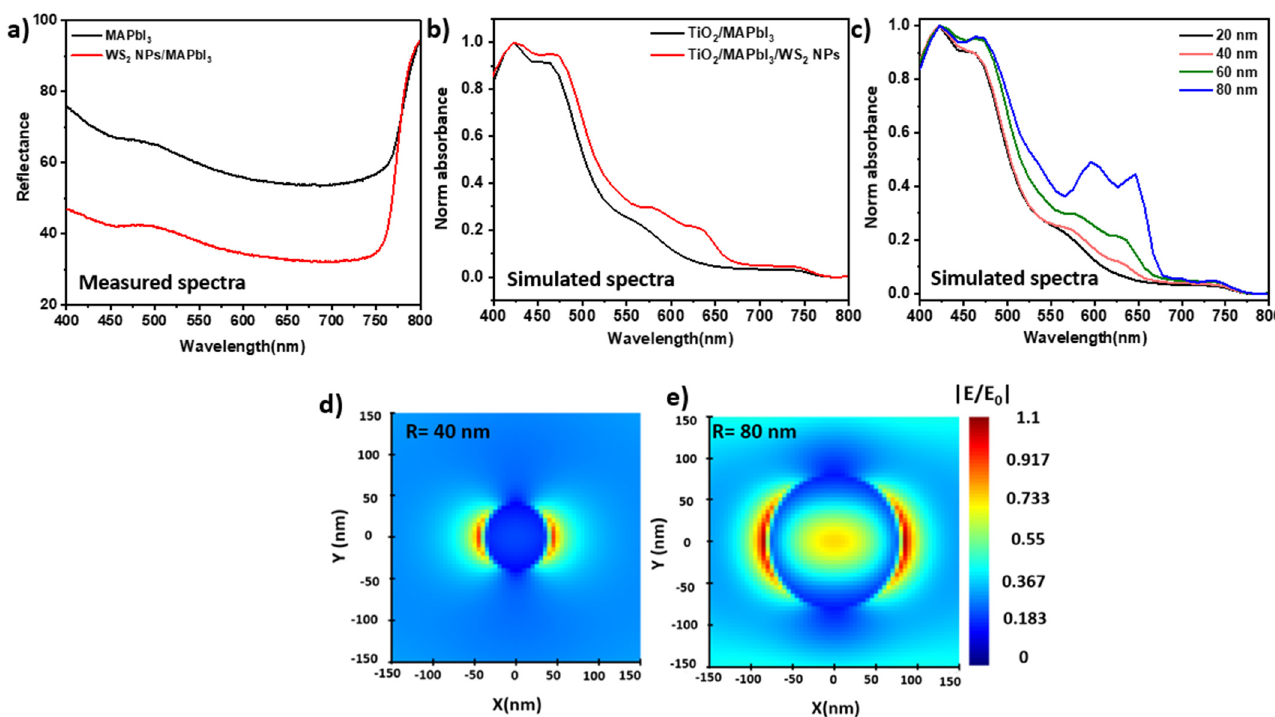
Figure 3. ( a ) Reflectance spectrum of MAPbI 3 and WS 2 NPs/MAPbI 3 , ( b ) simulated absorption spectrum of MAPbI 3 /WS 2 NPs and MAPbI 3 /WS 2 NPs/TiO 2 , ( c ) simulated absorption spectrum of WS 2 NPs with different radius, ( d , e ) simulated electric field distribution at 710 nm of WS 2 NPs with radius of ( d ) 40 nm ( e ) 80 nm.